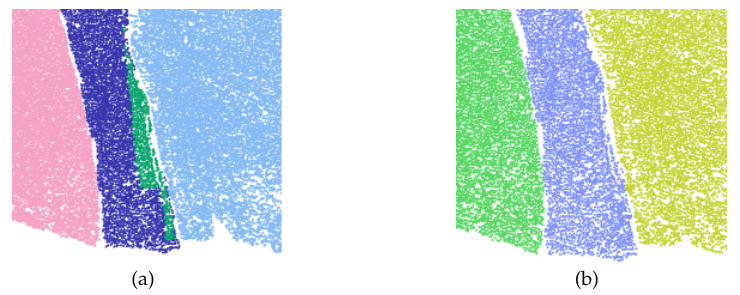
Figure 4. Controlling cumulative errors. ( a ) No limitation; ( b ) θ = 5 ◦